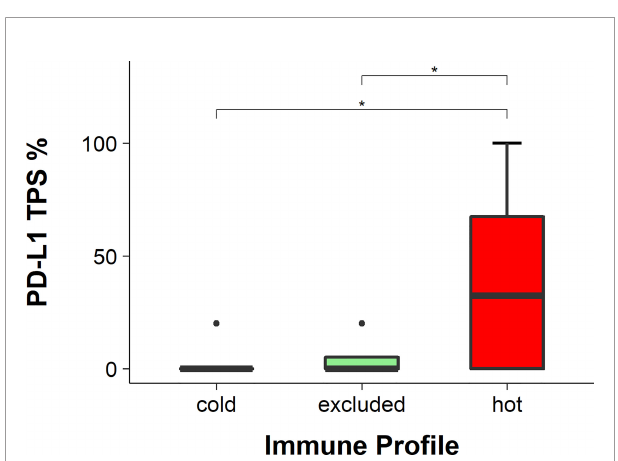
FIGURE 8 | Programmed death-ligand 1 (PD-L1) scores in hot, cold, and excluded head and neck squamous cell carcinomas (HNSCC; tumor positivity score, TPS). The TPS of PD-1 was the highest in hot tumors and the lowest in cold tumors, while in excluded tumors it was in between. The differences in the TPS of PD-1 between hot and excluded tumors and between hot and cold tumors were statistically signi fi cant (both p < 0.05), while the difference between cold and excluded tumors was not statistically signi fi cant ( p > 0.05), * means